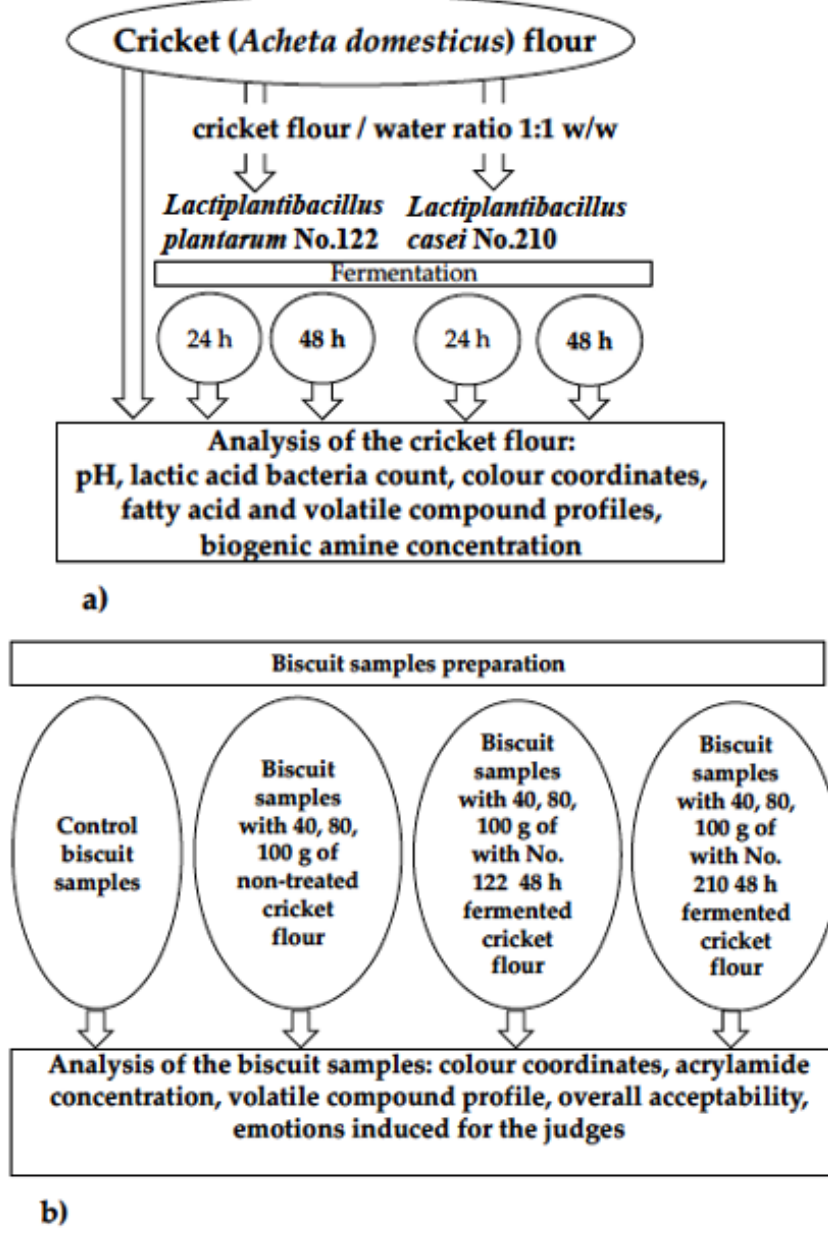
Figure 1. Schematic representation of the experimental design in this study: ( a ) scheme of the experiment with cricket flour; and ( b ) scheme of the experiment with biscuit samples.